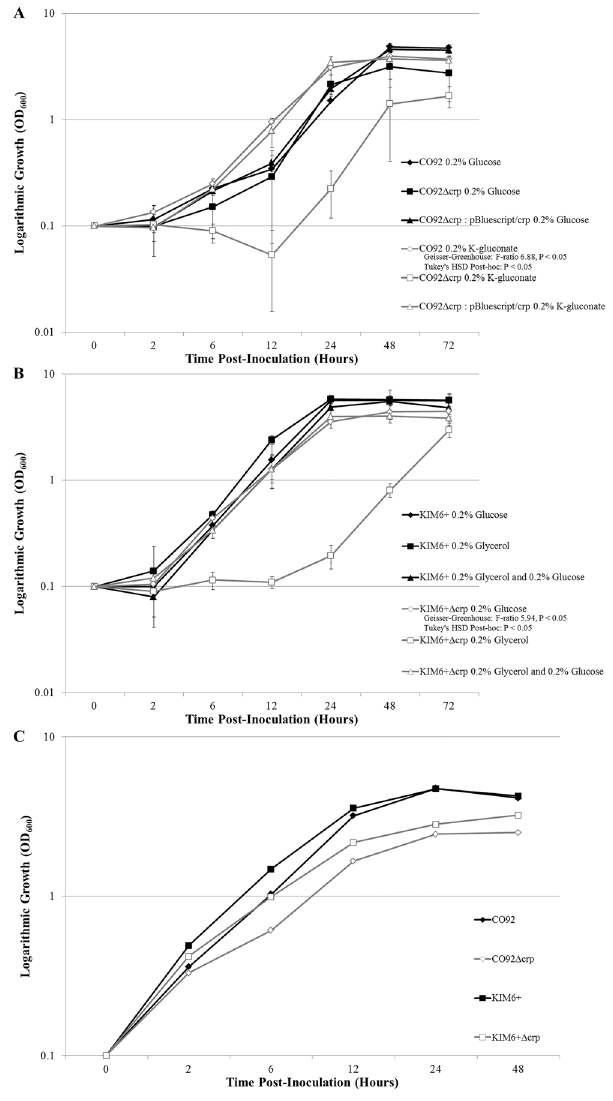
Fig 1. Y . pestis crp -deficient Mutant 26°C Growth Kinetics. (A) Growth curves of CO92, CO92 Δ crp , and plasmid complemented CO92 Δ crp : pBluescript/ crp when grown in BCS medium supplemented with 0.2% glucose or 0.2% K-gluconate. Growth of the CO92 crp -deficient mutant when cultured in medium supplemented with 0.2% K-gluconate was significantly impaired relative to all other bacterial strain and media conditions (Tukey ’ s HSD P < 0.05). (B) Growth curves of KIM6+ and KIM6+ Δ crp when cultured in BCS medium supplemented with either 0.2% glucose, 0.2% glycerol, or a combination of both 0.2% glucose and 0.2% glycerol. Growth of the KIM6+ crp -deficient mutant when cultured in medium solely supplemented with 0.2% glycerol was significantly impaired relative to all other bacterial strain and media conditions (Tukey ’ s HSD P < 0.05). (C) Growth kinetics of the CO92 and KIM6+ crp -deficient mutants and respective isogenic controls when grown in HIB medium at